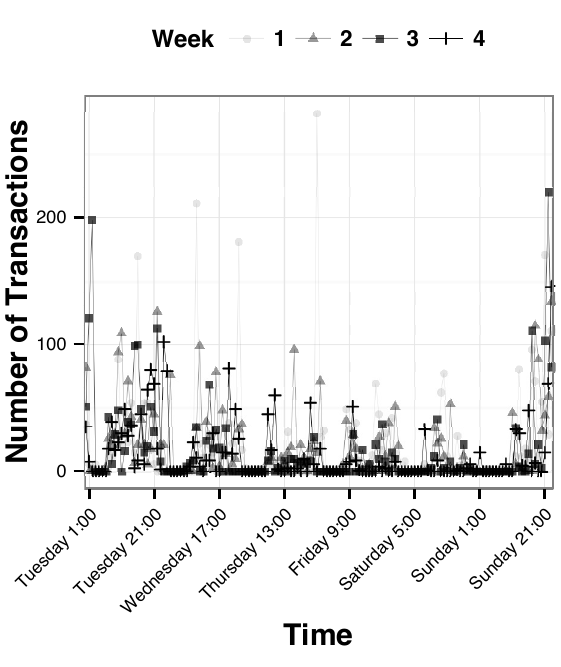
Figure A.4: Experiment 1: Trading Activity over the four weeks of